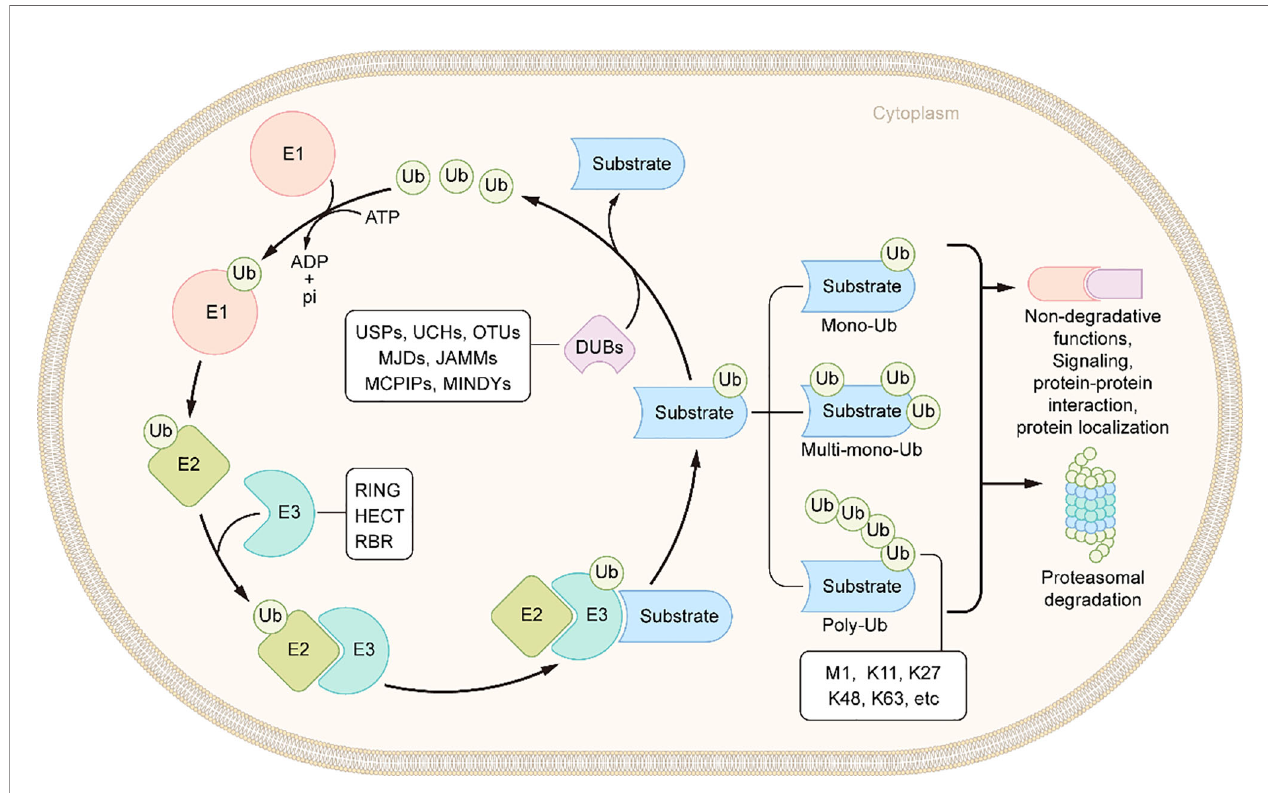
FIGURE 2 | Schematic of ubiquitination and deubiquitination. In an ATP-dependent way, the E1 enzyme activates ubiquitin, forming a covalent thioester connection between ubiquitin and the E1 cysteine residue. Then, ubiquitin is transported to an E2 conjugating enzyme. Finally, an E3 ligase aids or catalyzes the transfer of ubiquitin from an E2 to a substrate, generally through a lysine side chain. DUBs remove the ubiquitin molecules from the